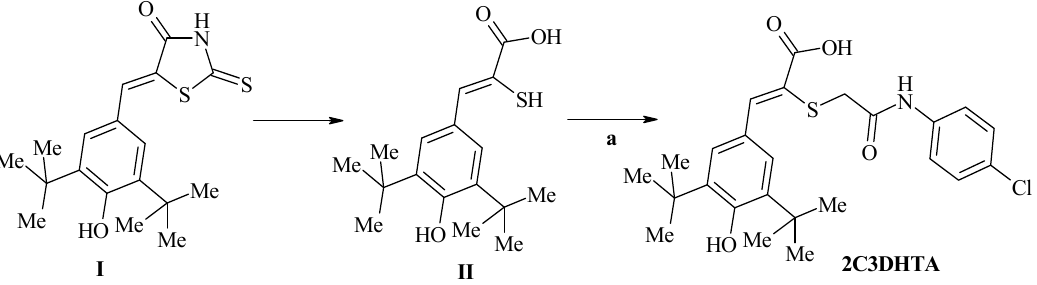
Figure 1. Synthesis of 2-[(4-chlor-phenyl-carbamoyl)-methyl]-3-(3,5-di-tert-butyl-4-hydroxyphenyl)- acrylic acid (2C3DHTA). Reagents, conditions and yields: 2,4 ′ -dichloroacetanilide, EtOH, reflux 3 h, 72%.